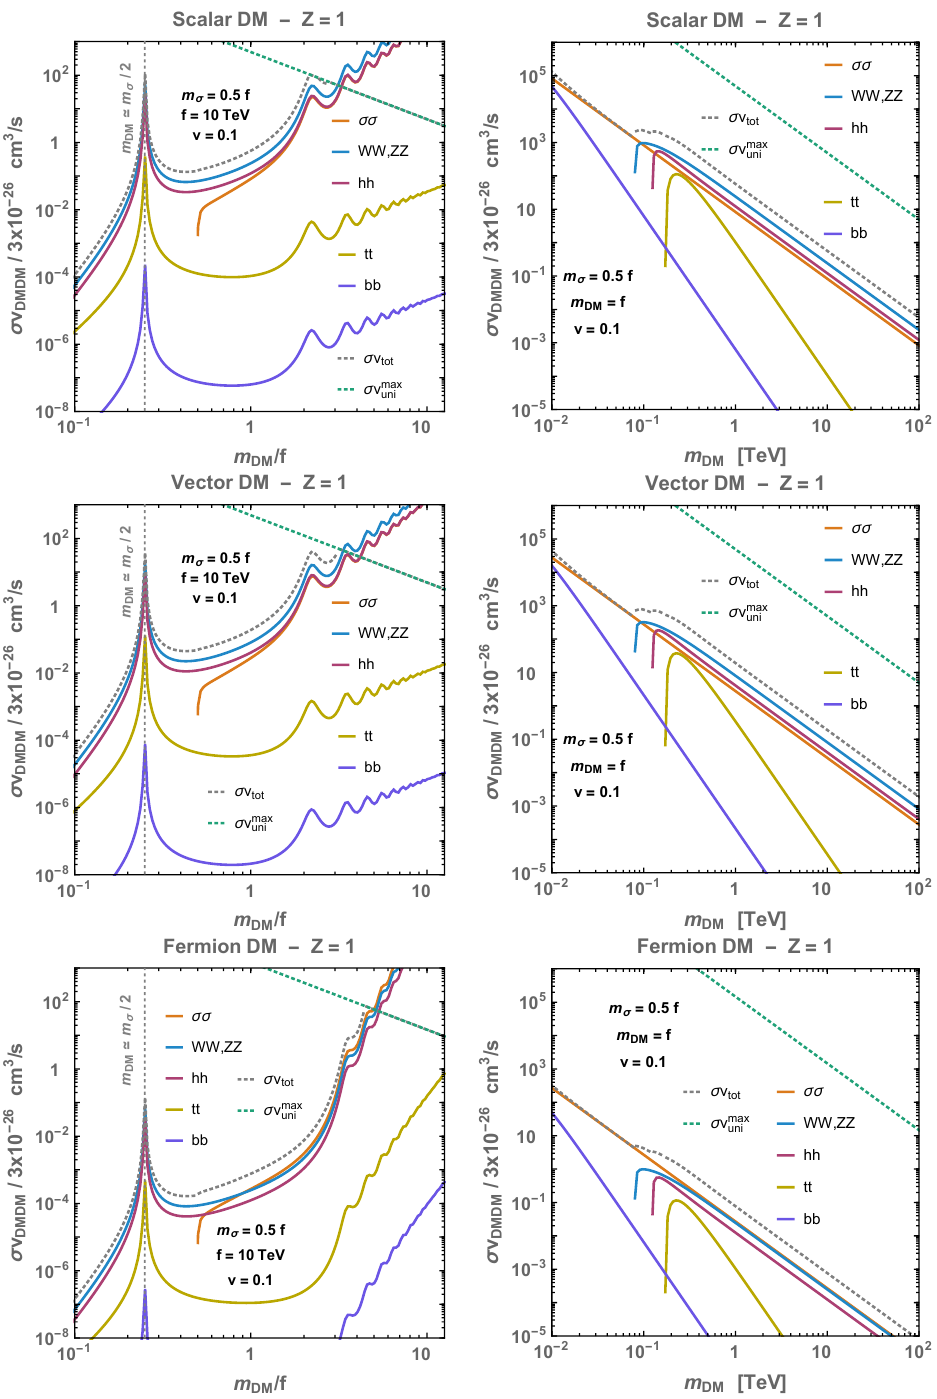
Figure 19 . DM annihilation cross-section in the scenarios where DM is a scalar ( top ), a vector ( middle ) or a fermionic ( bottom ) resonance of the confining sector. On the left panels we fix the confining scale f = 10 TeV while on the right panels, we fix it equal to the DM mass f = m . For DM all plots, we set the dilaton mass to m = 0 . 5 f and the relative velocity to v = 0 . 1 . The wiggles σ rel are consequences of Sommerfeld effects, cf.